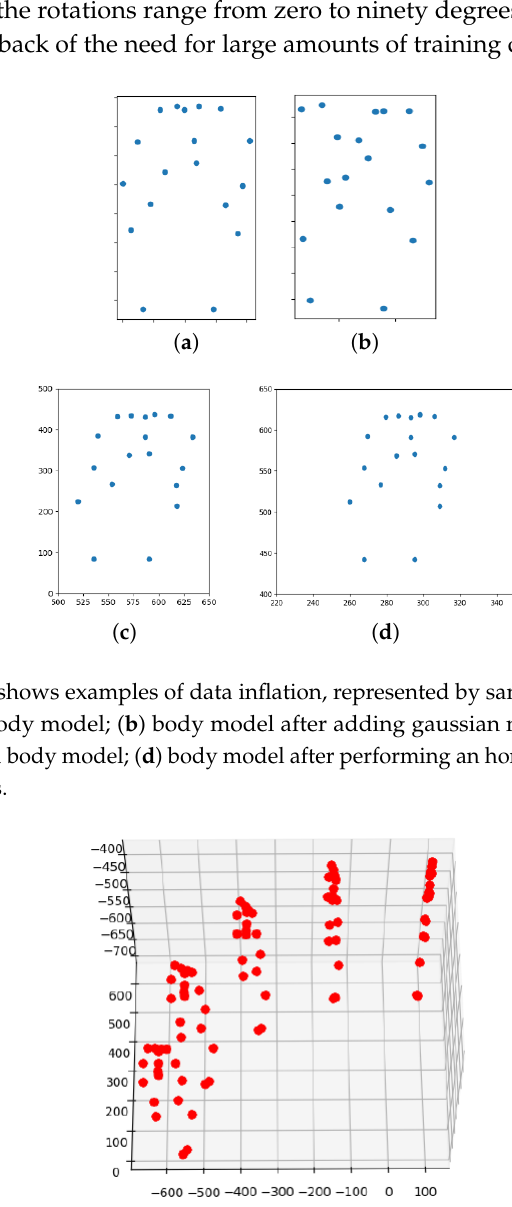
Figure 14. This figure shows examples of data inflation, represented by samples of the 18 nodes body model, due to rotations of the model, from zero to ninety